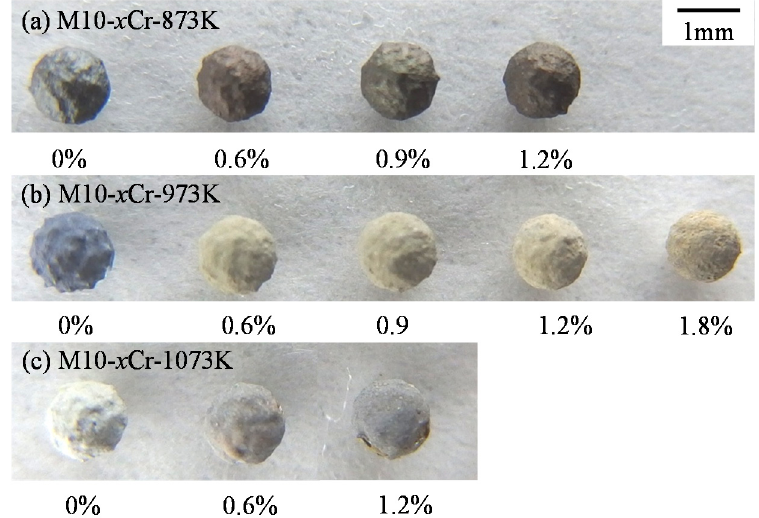
Figure 48. Photograph of the samples.